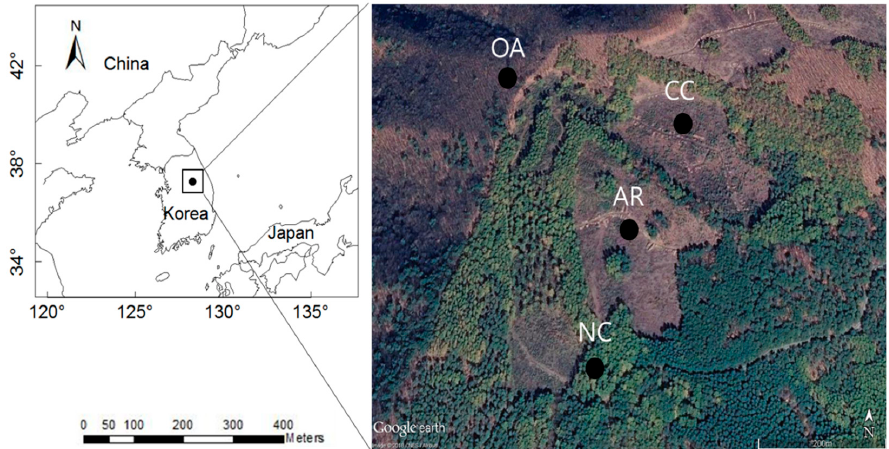
Figure 1. Location of the study sites in South Korea. CC: clearcutting area; AR: aggregated retention area; NC: no cutting area; OA: Mongolian oak area.